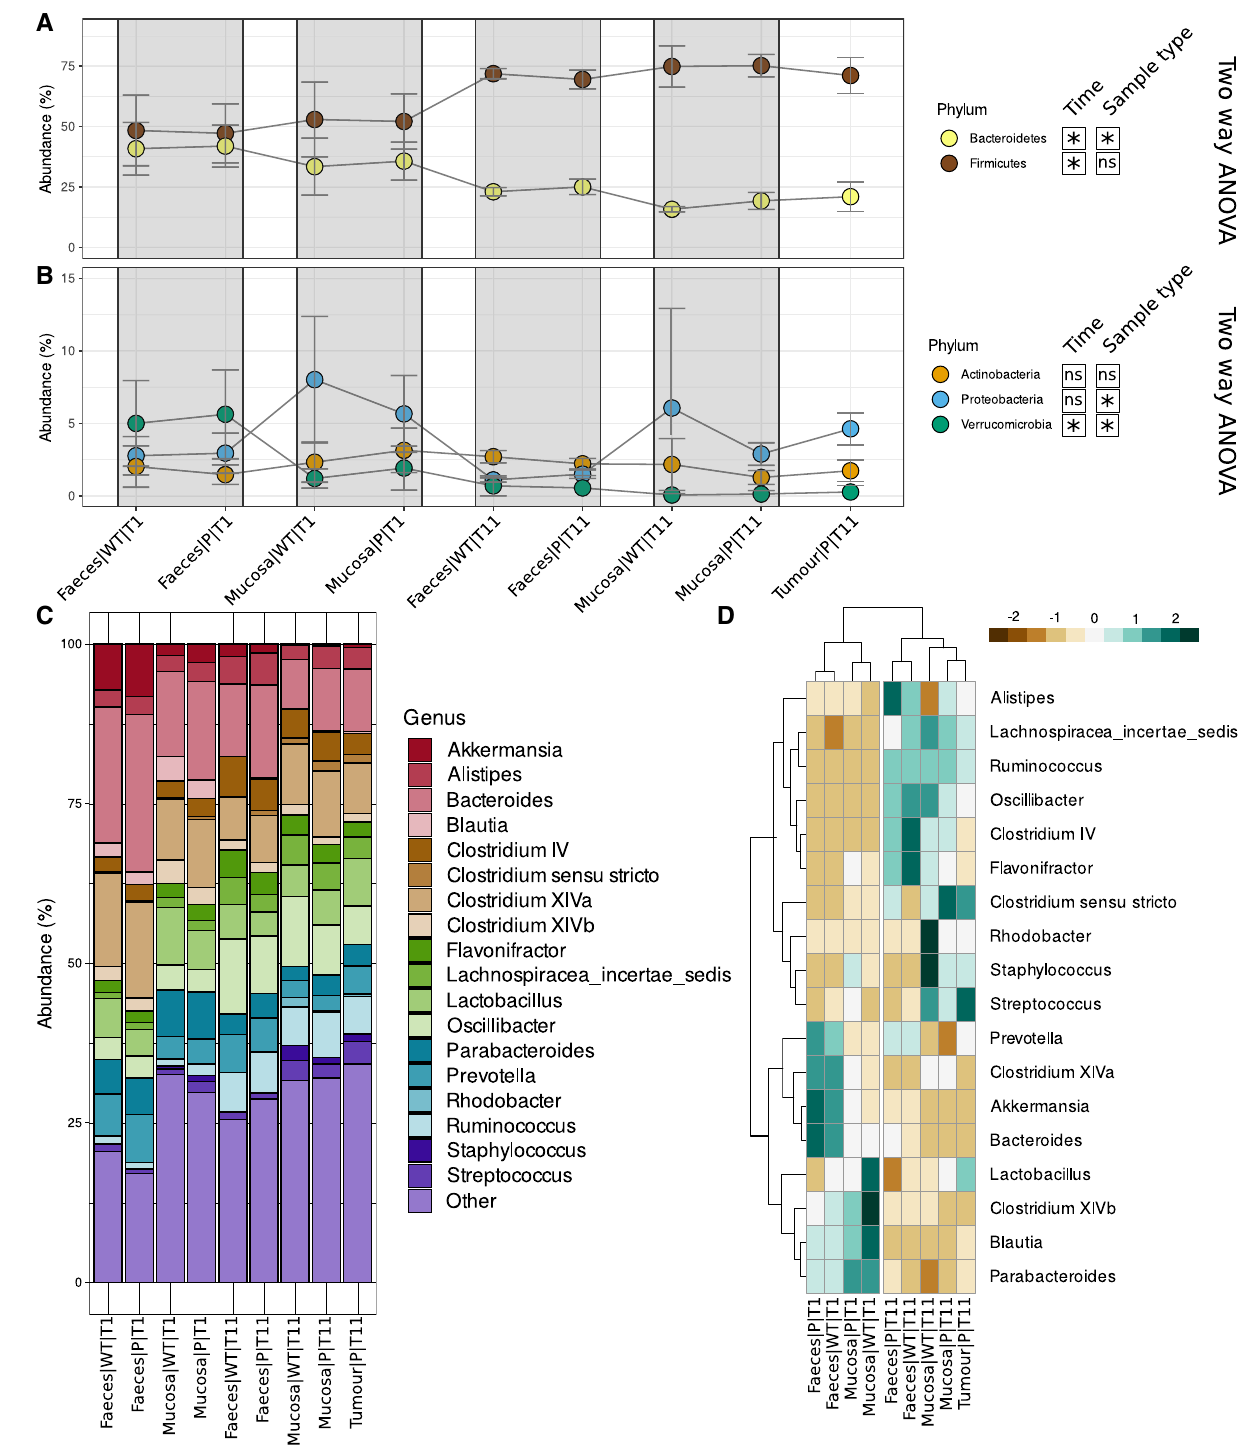
Figure 3. Relative abundances of phyla and genera (only phyla and genera with abundance > 5% in at least one sample were represented). ( A,B ) Composition of bacterial communities at the phylum level, grouped for sample type (faeces-mucosa) and genotype (Pirc-wt). Gray rectangles highlight couples of Pirc and wt samples from the same time point. Two-way ANOVA testing for time and genotype or for sample and genotype: *Significant effect of time (age) or sample type (faeces vs mucosa); ns non significant; ( C ) composition of bacterial communities at the genus level, grouped for sample type and genotype groups. Genera with relative abundance lower than 5% were grouped in the “Other” category. ( D ) Heatmap highlighting abundance distribution of genera (only genera at abundance higher than 5% were retained) among sample type and genotype